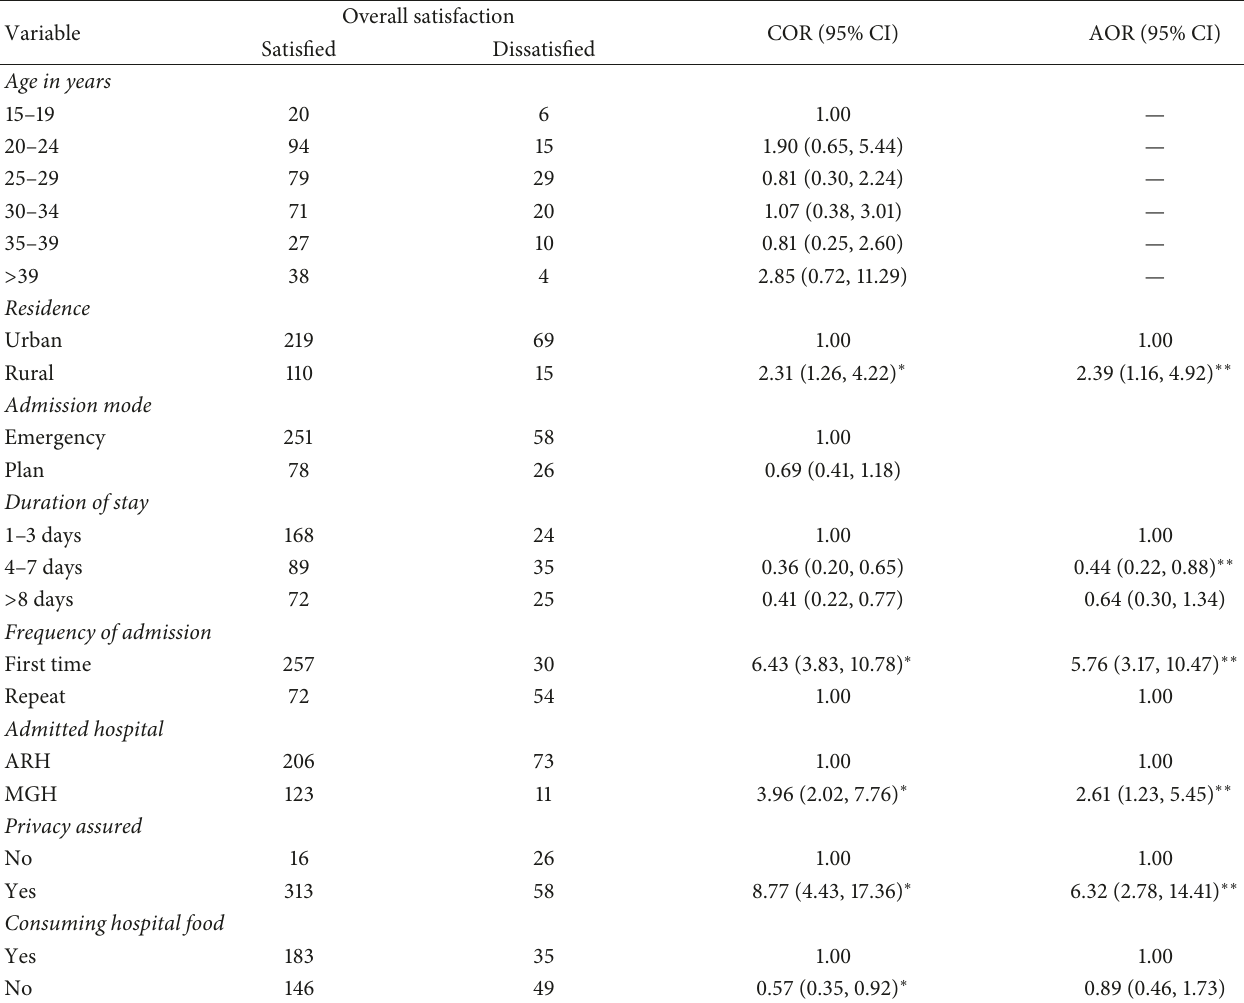
Table 4: Factors associated with patient satisfaction among clients admitted to obstetrics and gynecology wards of public hospitals in Mekelle town, Tigray Region,